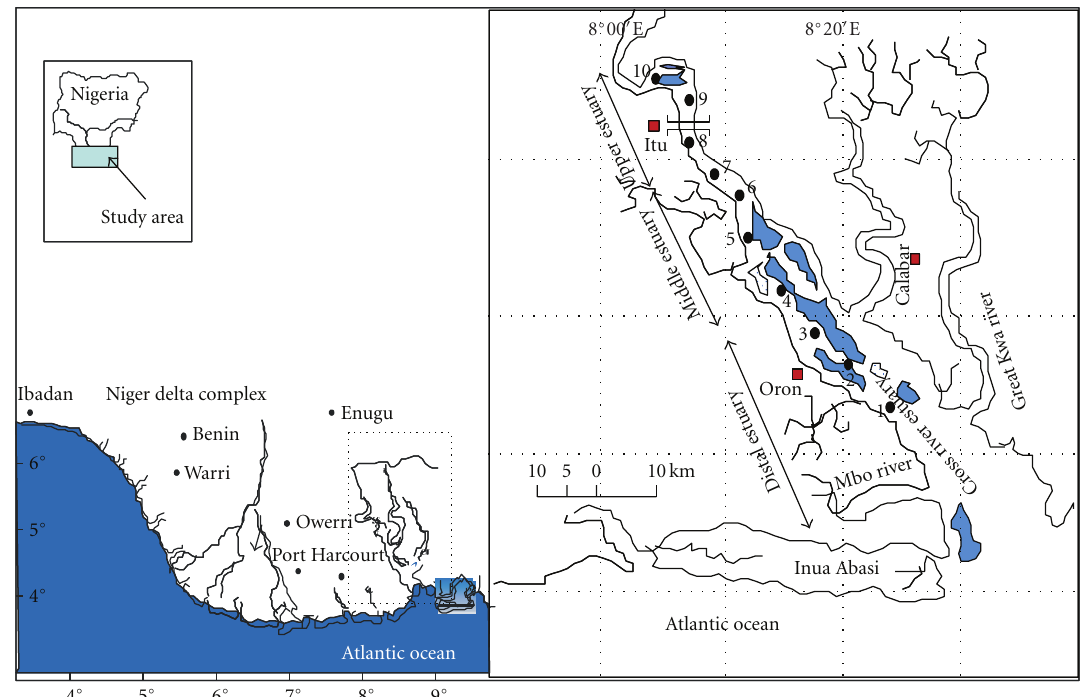
Figure 1: Map of the southeastern part of the Niger Delta of Nigeria showing the sampling locations in the Cross-River